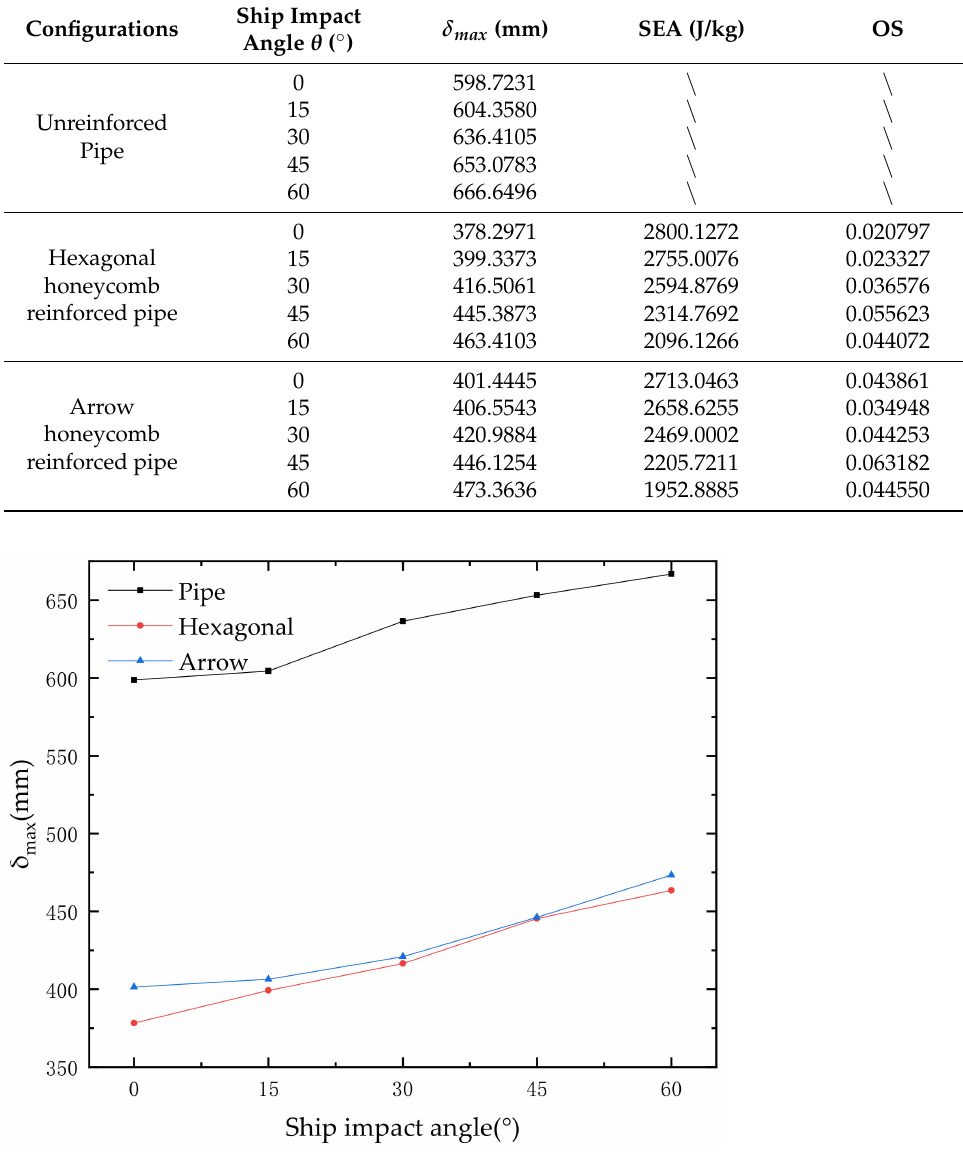
Table 7. Crashworthiness indices of three structures at different impact angles.